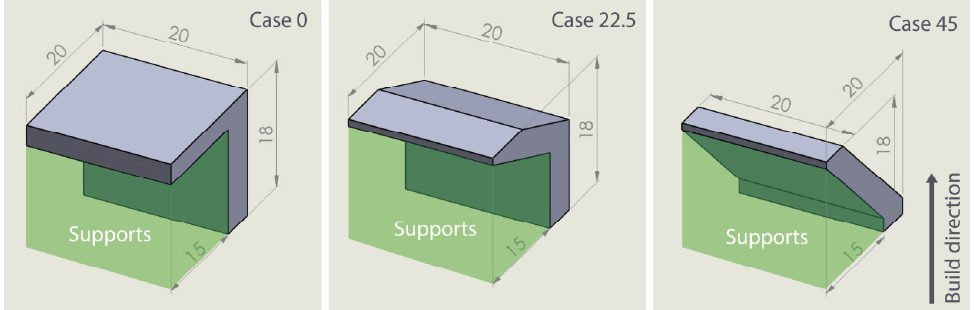
Figure 2. Specimen geometry, supported area, and build